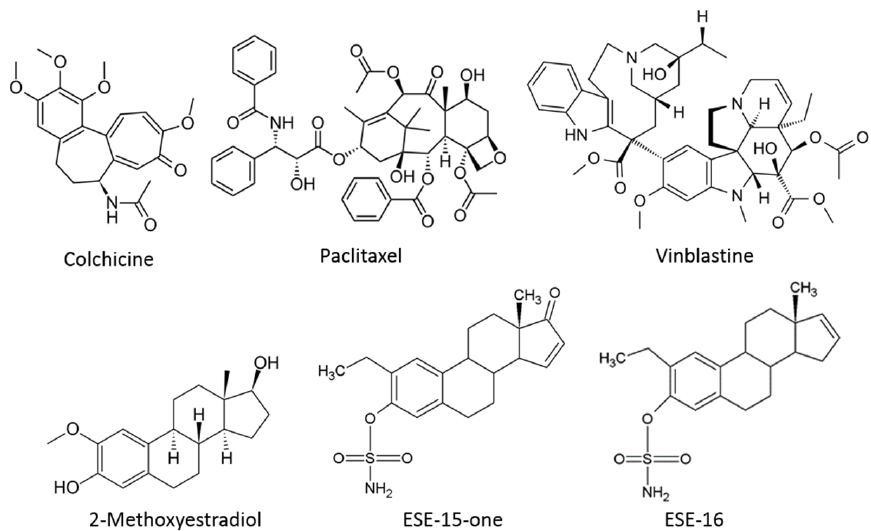
Figure 1. Chemical structures of various microtubule disrupting agents. Colchicine and vinblastine are classical microtubule destabilizers which affect dynamic instability parameters and depolymerize microtubules (concentration dependent). Paclitaxel is an example of a microtubule stabilizing agent. The bottom 3 compounds illustrate the structures of (17 beta)-2-methoxyestra-1,3,5(10)-triene-3,17-diol (2-methoxyestradiol) and the in silico-designed analogues ESE-15-one (2-ethyl-3- O -sulphamoyl-estra-1,3,5(10),15-tetraene-3-ol-17-one) and ESE-16 (2-ethyl-3- O -sulphamoyl-estra-1,3,5(10)16-tetraene) with their respective substitutions at position C2, C3 and C17 of the parent compound [20].